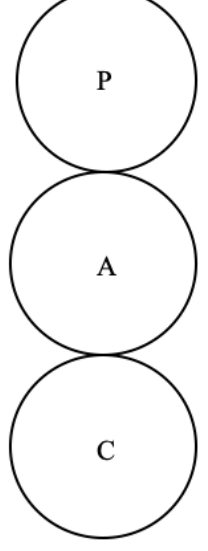
Figure 2: Integrated PAC Scientist Contaminated Adult